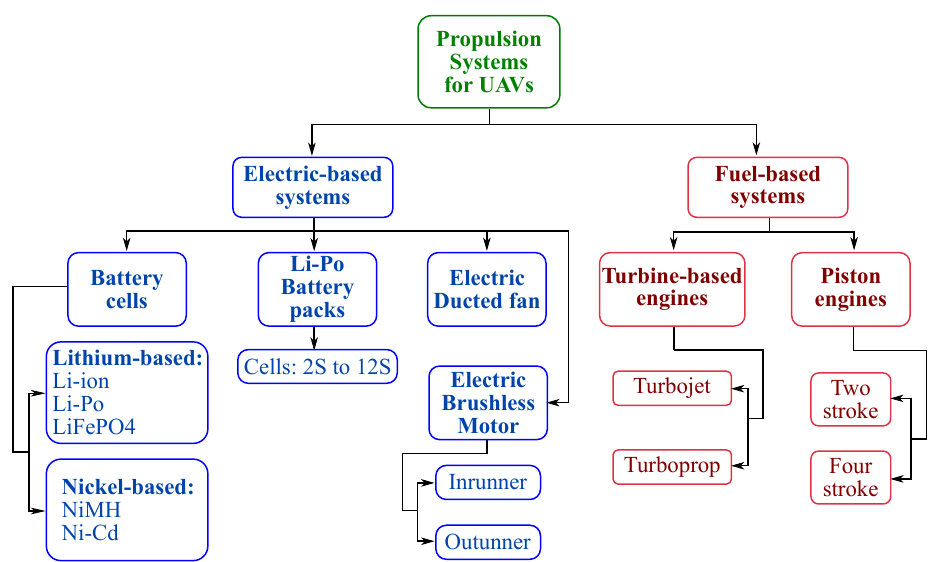
Figure 1. Propulsion systems for UAVs addressed in this